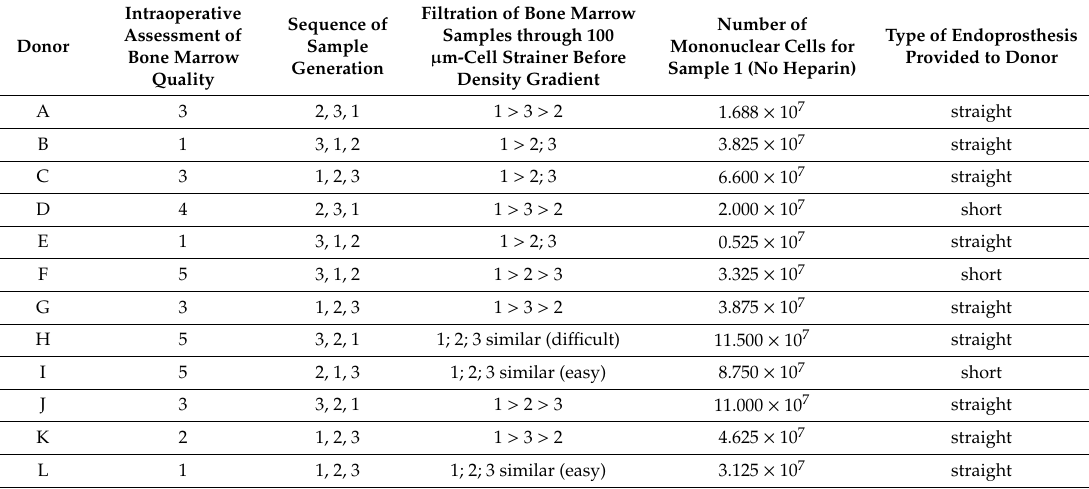
Table 2. Information of bone marrow spiking with